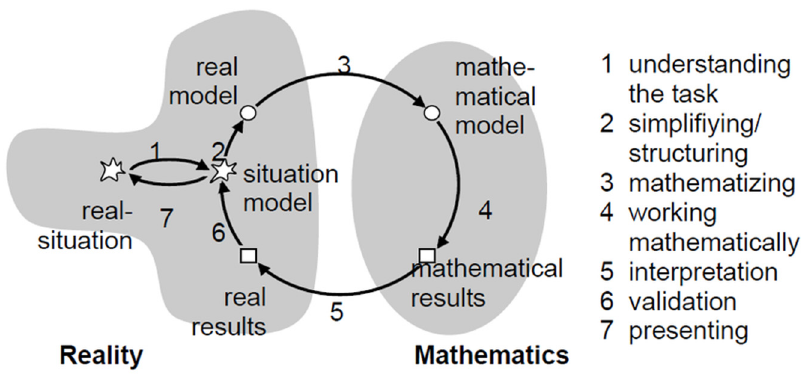
Figure 1. Mathematical modelling cycle proposed by Blum and Lei β [30].